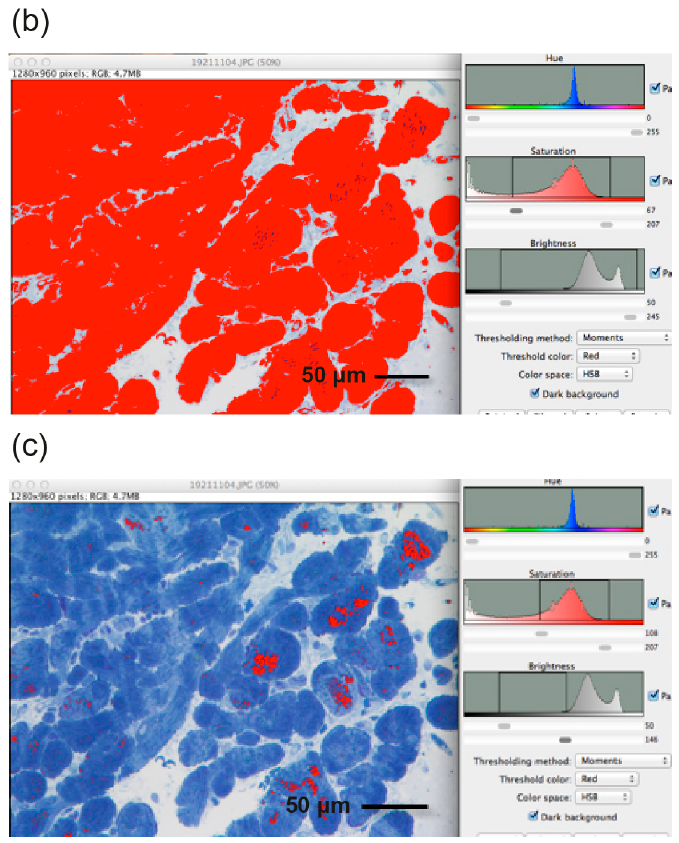
Figure 2. Image processing using ImageJ software. ( a ) Cardiomyocyte sample from a single Fabry patient with toluidine blue staining; ( b ) Total area of the cardiomyocytes (in red); ( c ) Area of globotriaosylceramide (Gb3) deposition within the cardiomyocytes. The percentage area of Gb3 deposition was calculated from these two values, using ImageJ.